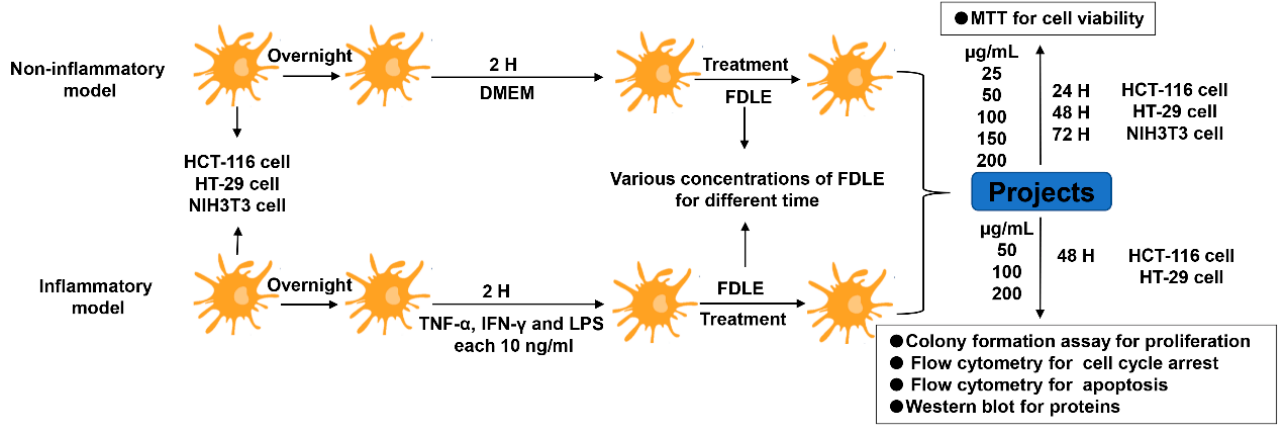
Figure 1. The experimental design of non-inflammatory and inflammatory models.